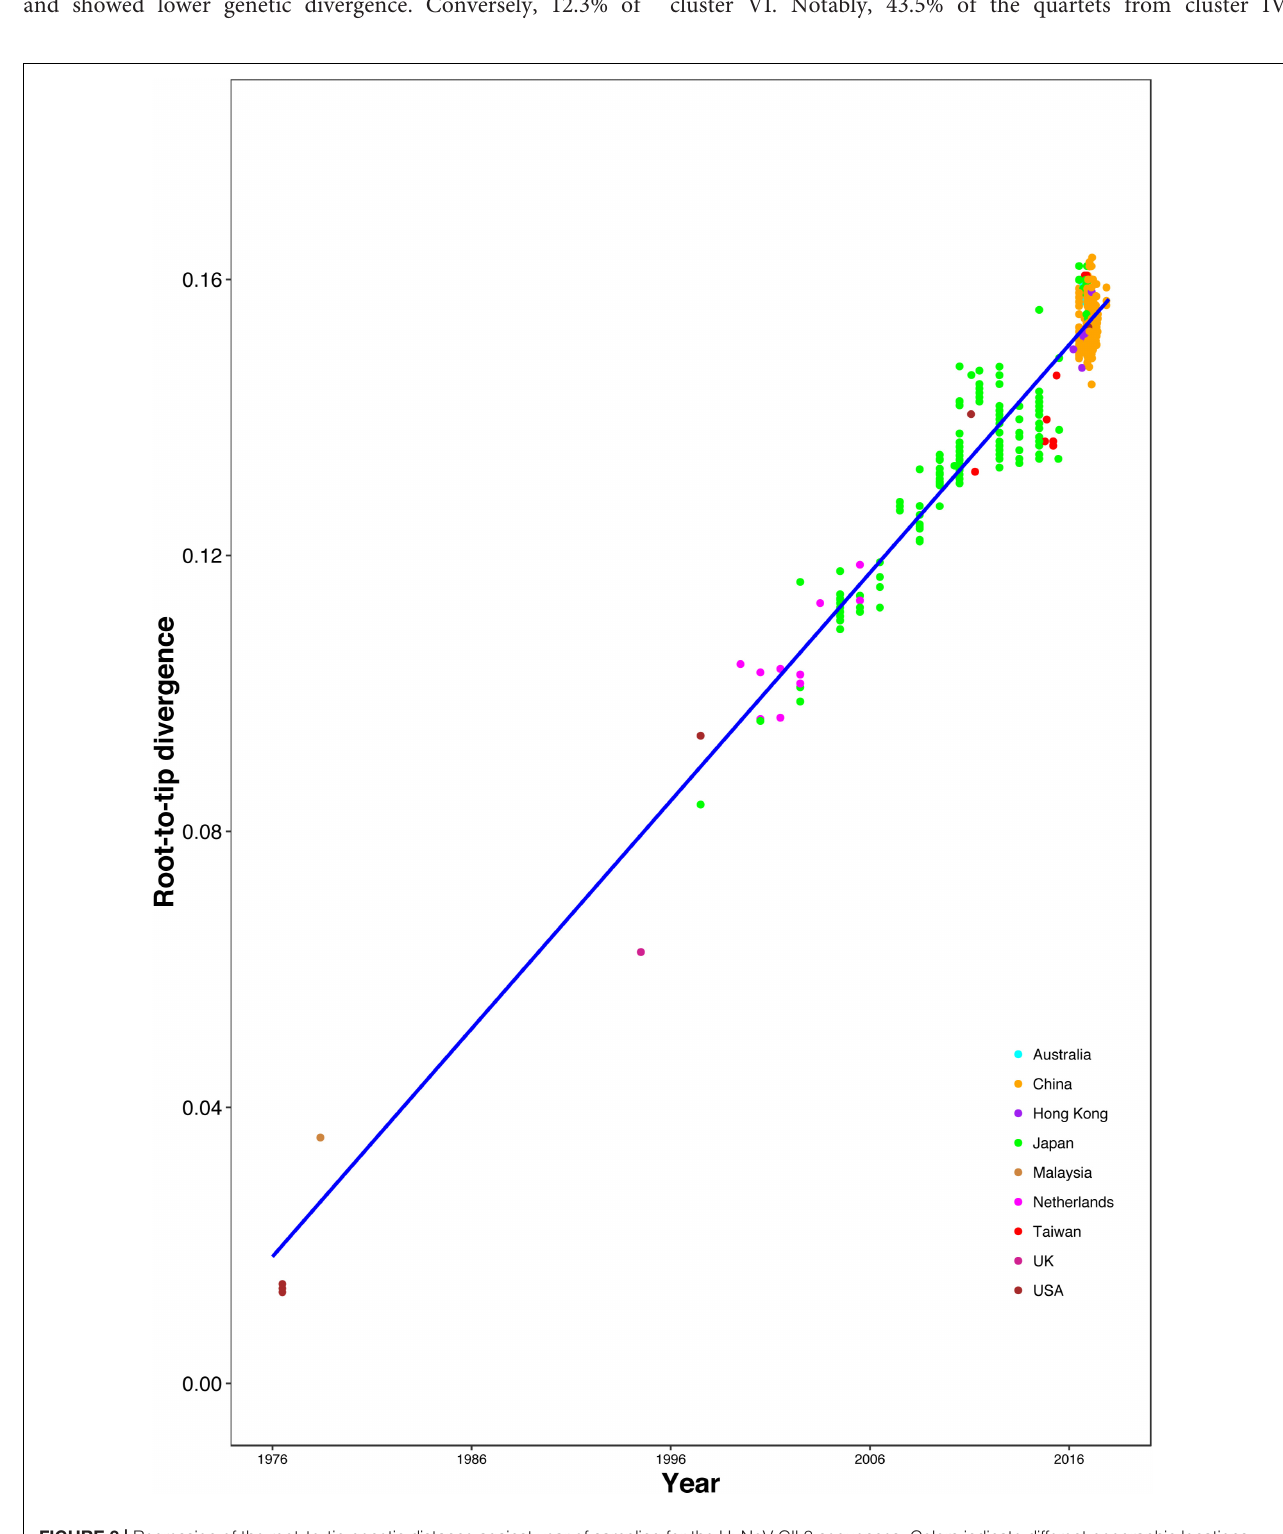
Frontiers in Microbiology |